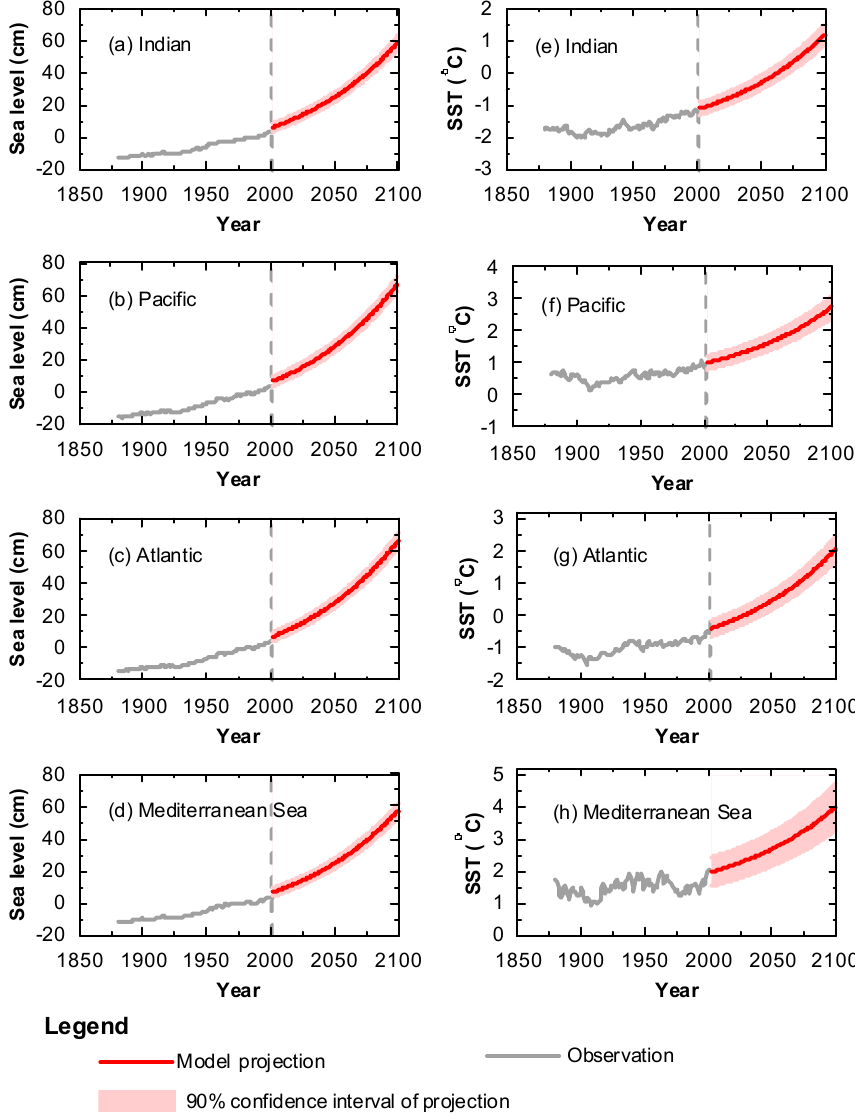
Figure 3. Sea level projections for the four regions of the World’s Oceans.